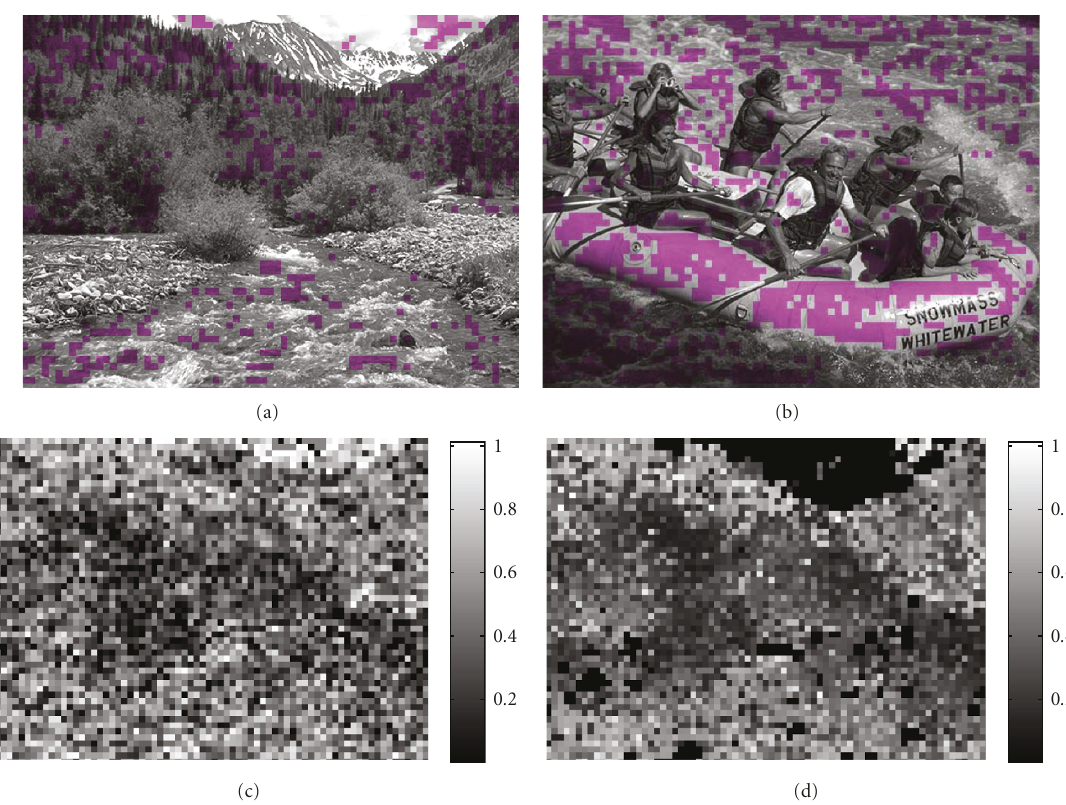
= 65) (a) and (b); (cid:19) H r map for the n 0 = 65 n 0